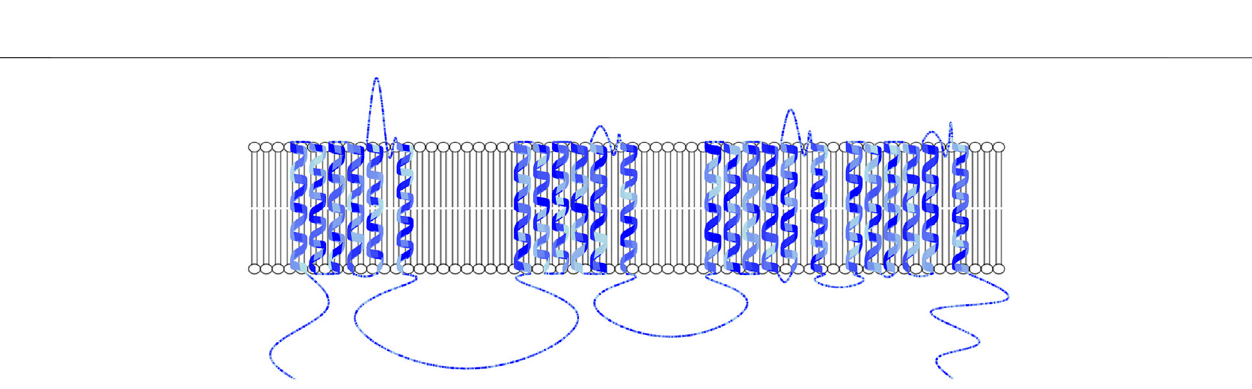
FIGURE 6 | Example of Naview ’ s property-based color map from lightblue to blue after loading a CSV containing a randomly valued property named “ Conservation ” ranging from 0 to 1 for each of the protein ’ s residues. Used color rule: “ ALL, by:Conservation,#ADD8E6;#0000FF, min;max ” . As such residues with a higher “ Conservation ” value are colored in a darker tone of blue. Helices are shown as cartoons and the membrane as a lipid bilayer. All loop residues are scaled to two